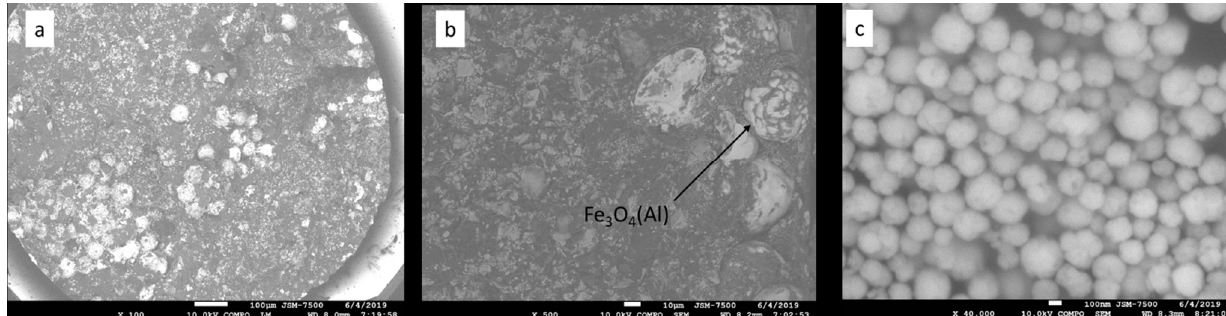
Figure 5. SEM images of the composite material FAC in a paraffin matrix with Fe 3 O 4 particles covered by Al nanoparticles at x 100 magnification ( a ) at 500x magnification ( b ) and the surface of the Fe 3 O 4 (Al) particle at 40,000x magnification ( c ).